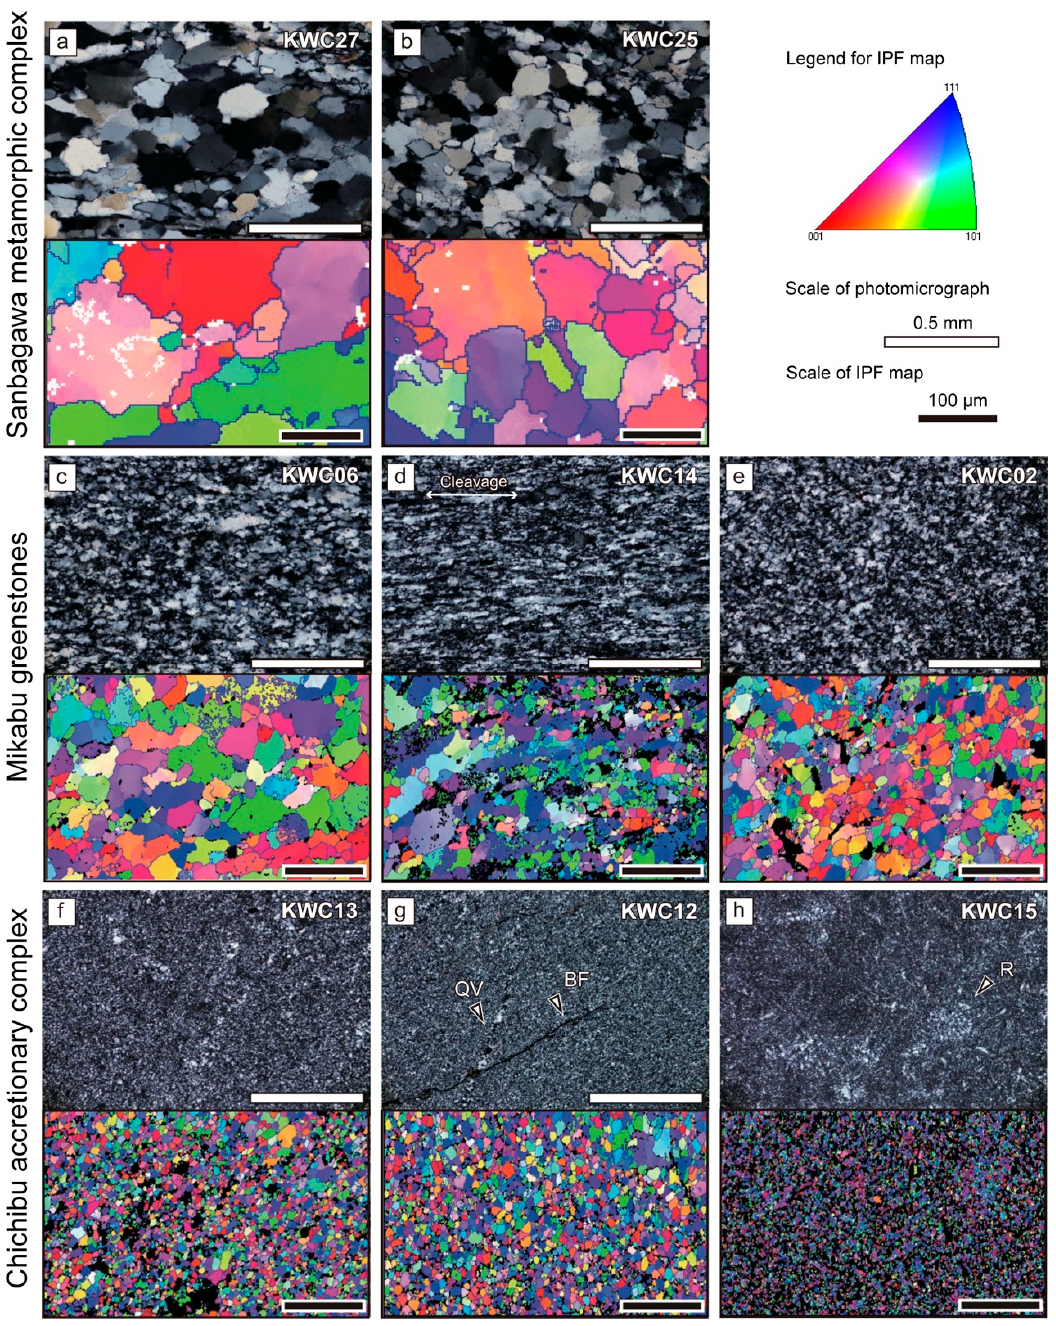
Figure 6. Microstructure of the quartz in siliceous rocks showing photomicrographs (upper panels) and inverse pole figure (IPF) maps from an EBSD analysis (lower panels): ( a ) sample KWC27, Sanbagawa metamorphic complex, garnet zone; ( b ) sample KWC25, Sanbagawa metamorphic complex, chlorite zone; ( c ) sample KWC06, Mikabu greenstones, Lower Unit; ( d ) sample KWC14, Mikabu greenstones, Upper Unit; ( e ) sample KWC02, Mikabu greenstones, Upper Unit; ( f ) sample KWC13, Chichibu accretionary complex, Kashiwagi Unit; ( g ) sample KWC12, Kashiwagi Unit; and ( h ) sample KWC15, Chichibu accretionary complex, Kamiyoshida Unit. QV: quartz vein; BF: brittle fracturing; and R: radiolarian fossil.